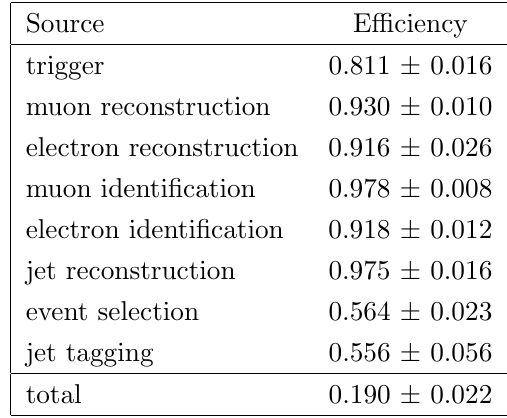
Table 1 . The e(cid:14)ciency to fully reconstruct and identify the